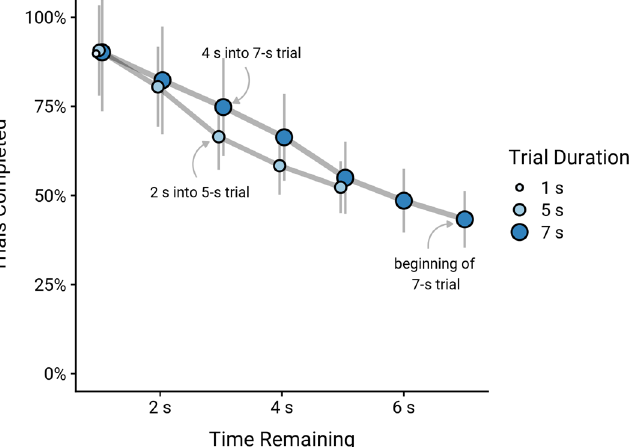
Figure 4. Trial completion by trial duration and time remaining. Point ranges indicate group means and 95% confidence intervals. Time remaining refers to durations of at most X seconds, e.g., if a monkey had tracked the target for 3.2 s, the sunk cost (time already spent tracking) was considered to be 3 s and the time remaining either 2 s (in a 5-s trial) or 4 s (in a 7-s